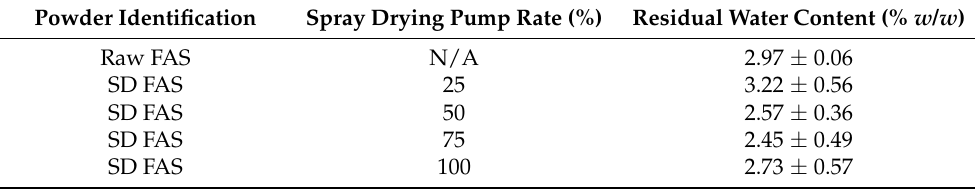
Table 4. Residual water content quantified by KFT. ( n = 3, mean ± standard deviation).